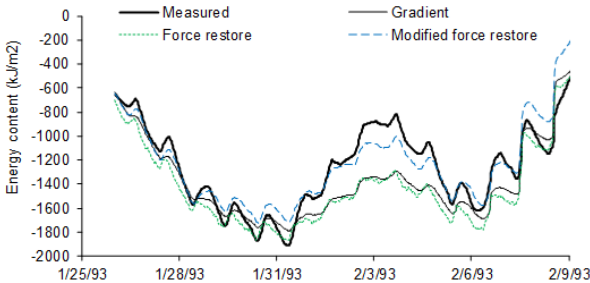
Figure 4. Comparisons of internal energy of snowpack during the first 2 freezing weeks at the USU drainage farm. Measured is the in- ternal energy of snowpack calculated from the temperature profile (Fig. 3). Gradient, Force restore, and Modified force restore repre- sent the modeled internal energy of snowpack using the equilibrium approach, the force-restore approach, and the modified force restore approach,